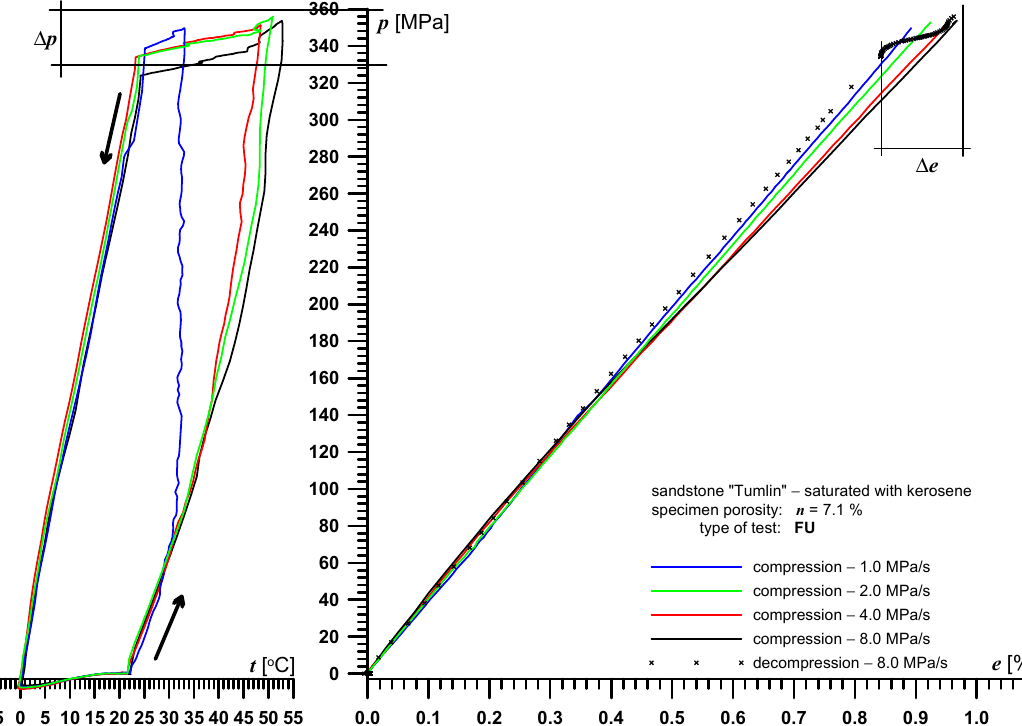
Figure 9. FU test result for Tumlin sandstone. Left : relationship between hydrostatic pressure and temperature (the arrows indicate the direction of change of hydrostatic pressure), right : relationship between hydrostatic pressure and volume change.